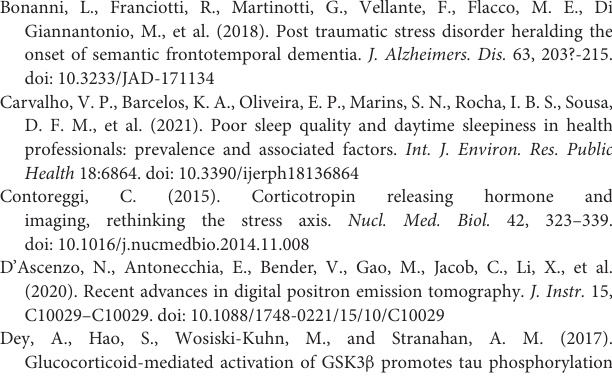
Supplementary Figure 1 | Phosphor-tau (Ser202/Thr205) is comparable between NS and SF. (A) Immunohistochemistry of phosphor-tau (Ser202/Thr205) with AT8 antibody in cortex and hippocampus in slices of NS and SF groups. Scale bar = 20 µ m. (B) Western blot of AT8 in SF cortex, using cortex of 12-month-old APP/PS1 mice as the positive control. (C) Silver staining of brain slices collected from cortex and hippocampus of mice in NS and SF groups as well as APP/PS1 mice. Scale bar = 20 µ